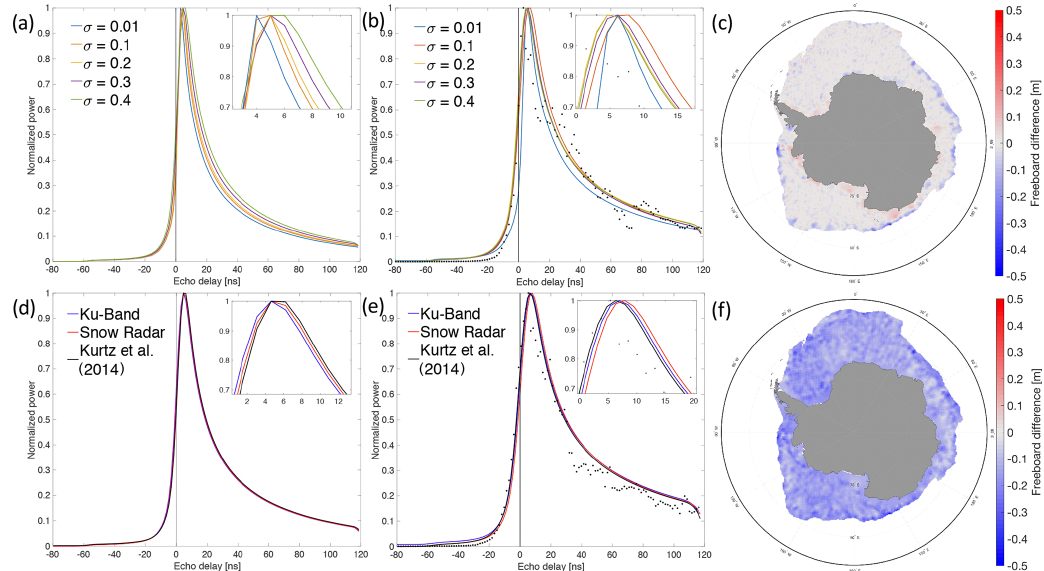
Figure 6. A sensitivity study of two initial guess parameters: the standard deviation of surface height, σ , and the total backscatter, σ 0 . (a) Modeled waveform (before fitting) varying the initial guess value of σ between 0.01 (very smooth surface) and 0.4 (rough surface). (b) Waveforms fit to CryoSat-2 data varying the initial guess value of σ between 0.01 and 0.4. (c) October 2016 average freeboard difference: σ = 0 . 35 as the initial guess – σ = 0 . 15 as the initial guess. Panel (d) as in (a) using three different backscatter parameterizations taken from the OIB Ku-band radar profile, snow radar profile, and Kurtz et al. (2014). Panel (e) as in (b) with the three different backscatter parameterizations. Panel (f) as in (c) showing Kurtz et al. (2014) backscatter as the initial guess – Ku-Band backscatter as the initial guess. Inlaid plots are zoomed in on the waveform peaks. The methodology for freeboard calculations is explained in Sect.